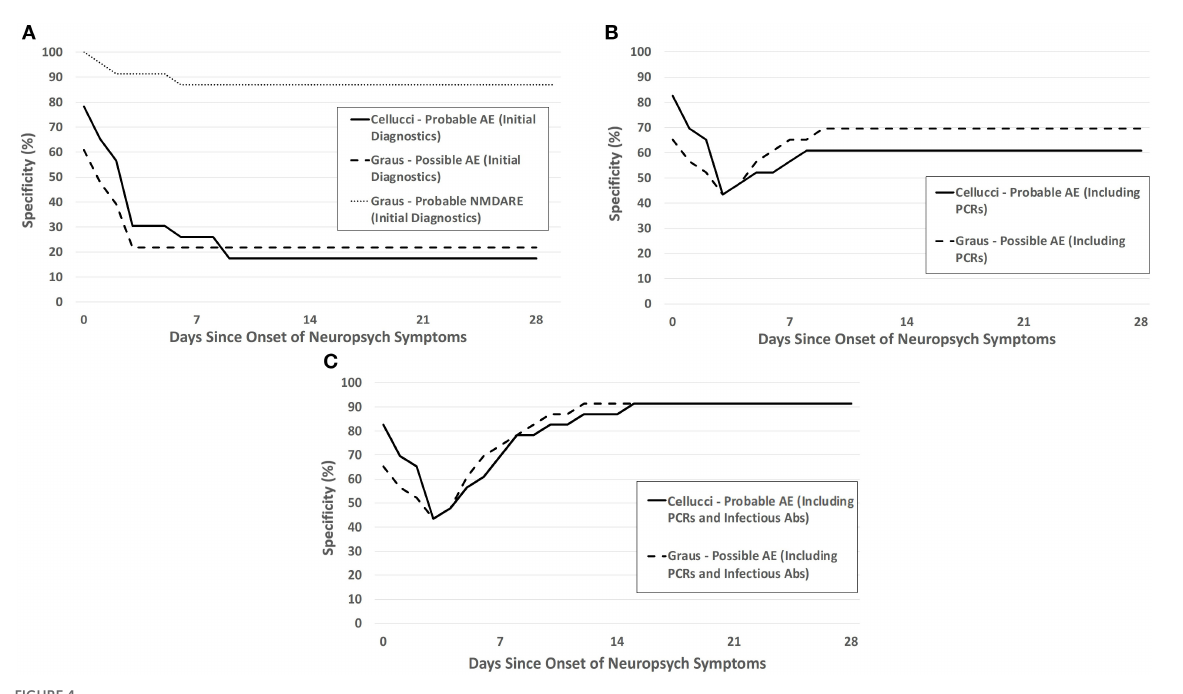
FIGURE4 Specificity of the Cellucci and Graus criteria for pediatric AE over the first month after neuropsychiatric symptom onset with (A) clinical symptoms and initial diagnostic testing (without infectious PCRs or antibodies), (B) clinical and initial diagnostics including PCR testing, (C) clinical and initial diagnostics including both PCR testing and infectious antibody